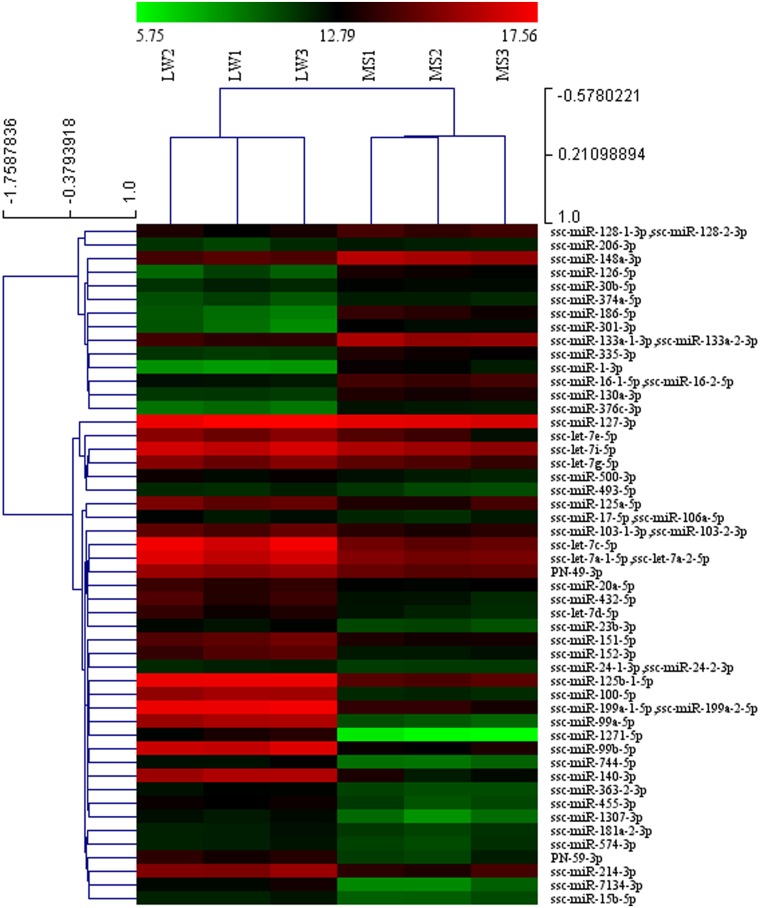
Hierarchical cluster analysis of the top 50 differentially expressed miRNAs (P < 0.05).Normalized log (base 2) data was hierarchically clustered by miRNA reads counts and is plotted as a heat map. LW1, LW2 and LW3 refer to the three biological replications of Large White pigs; MS1, MS2 and MS3 refer to the three biological replications of Meishan pigs.